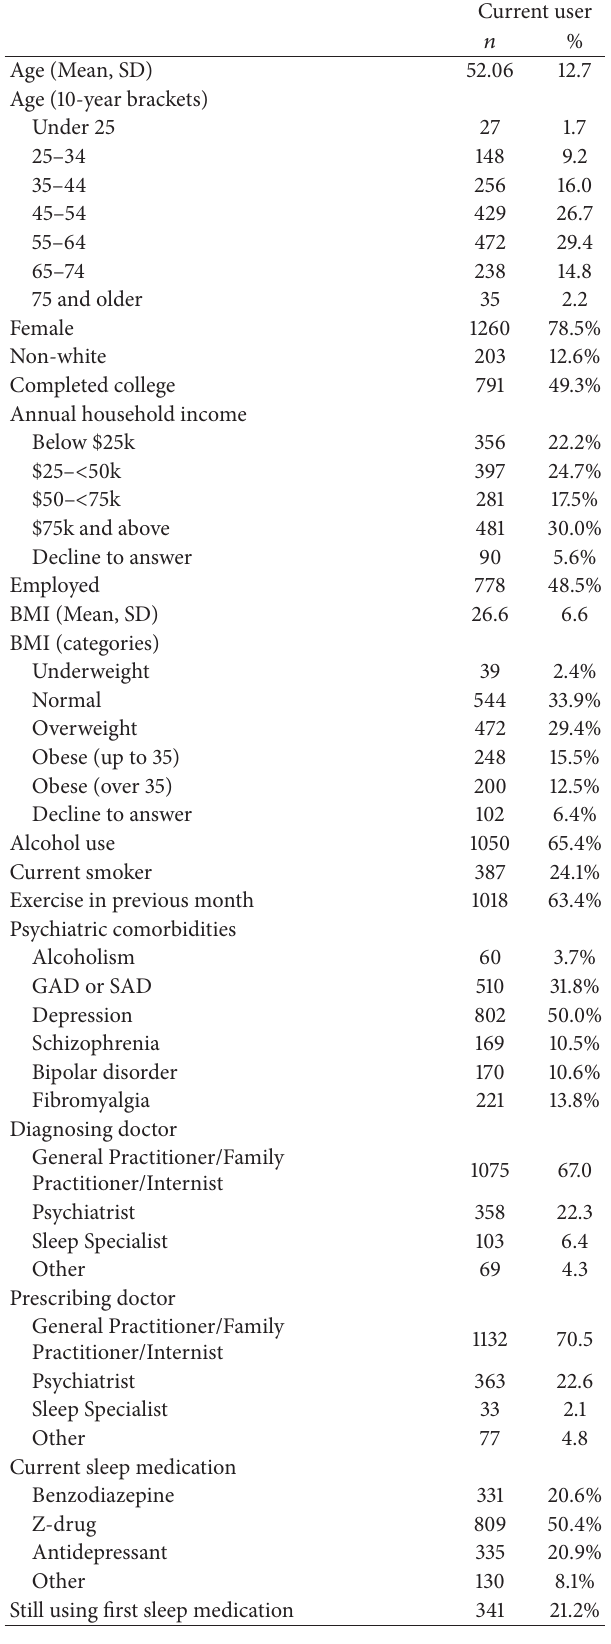
Table 1: Respondent